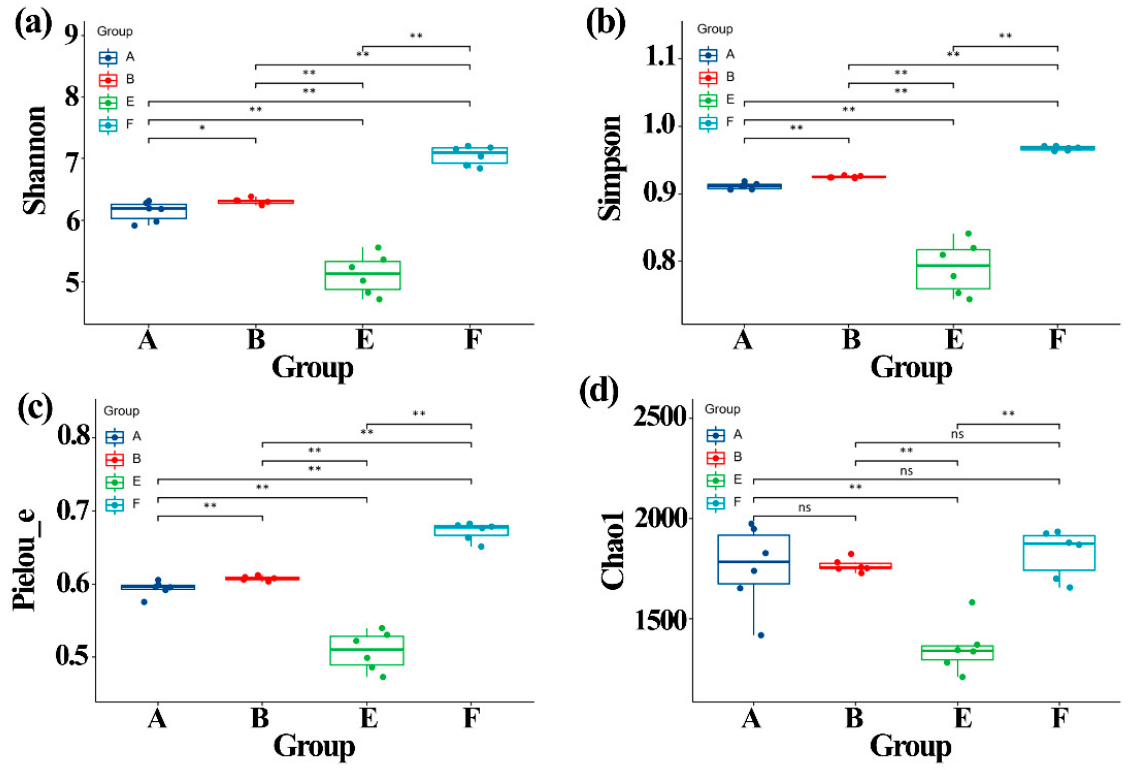
Figure 4. Effect of ZnONP on the alpha diversity of gut bacteria. ( a ) Shannon index; ( b ) Simpson index; ( c ) Pielou_e index; ( d ) Chao1. A: healthy children; B: healthy children + ZnONP; E: ASD children; F: ASD children + ZnONP. *: 0.05; **: 0.01; ns: not significance.